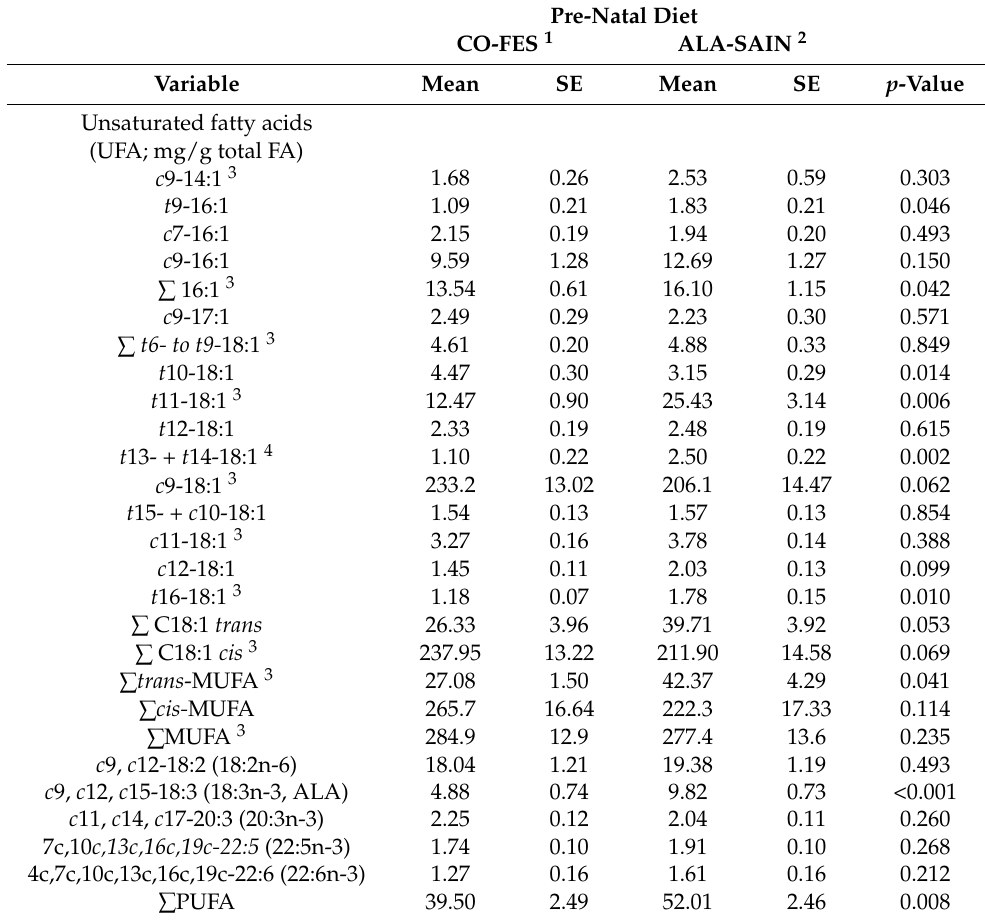
Table 3. Effect of pre-natal diet on colostrum unsaturated fatty acid profile. Only those unsaturated fatty acids with a contribution of more than 1 mg/g total FA and p -value lower than 0.1 are